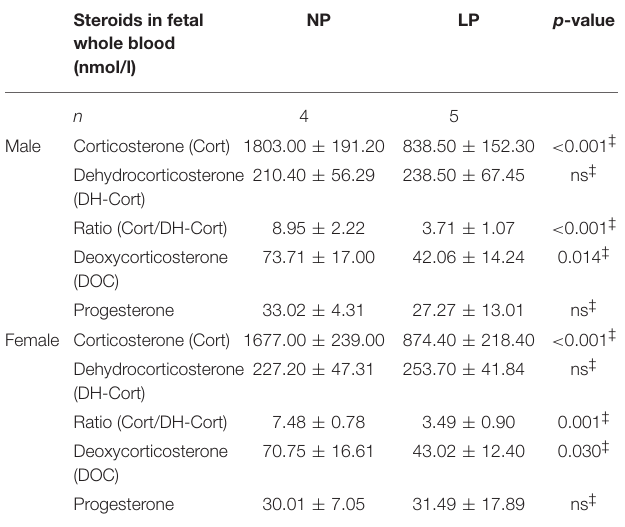
TABLE 6 | Steroid and CRH analysis of fetal brain.